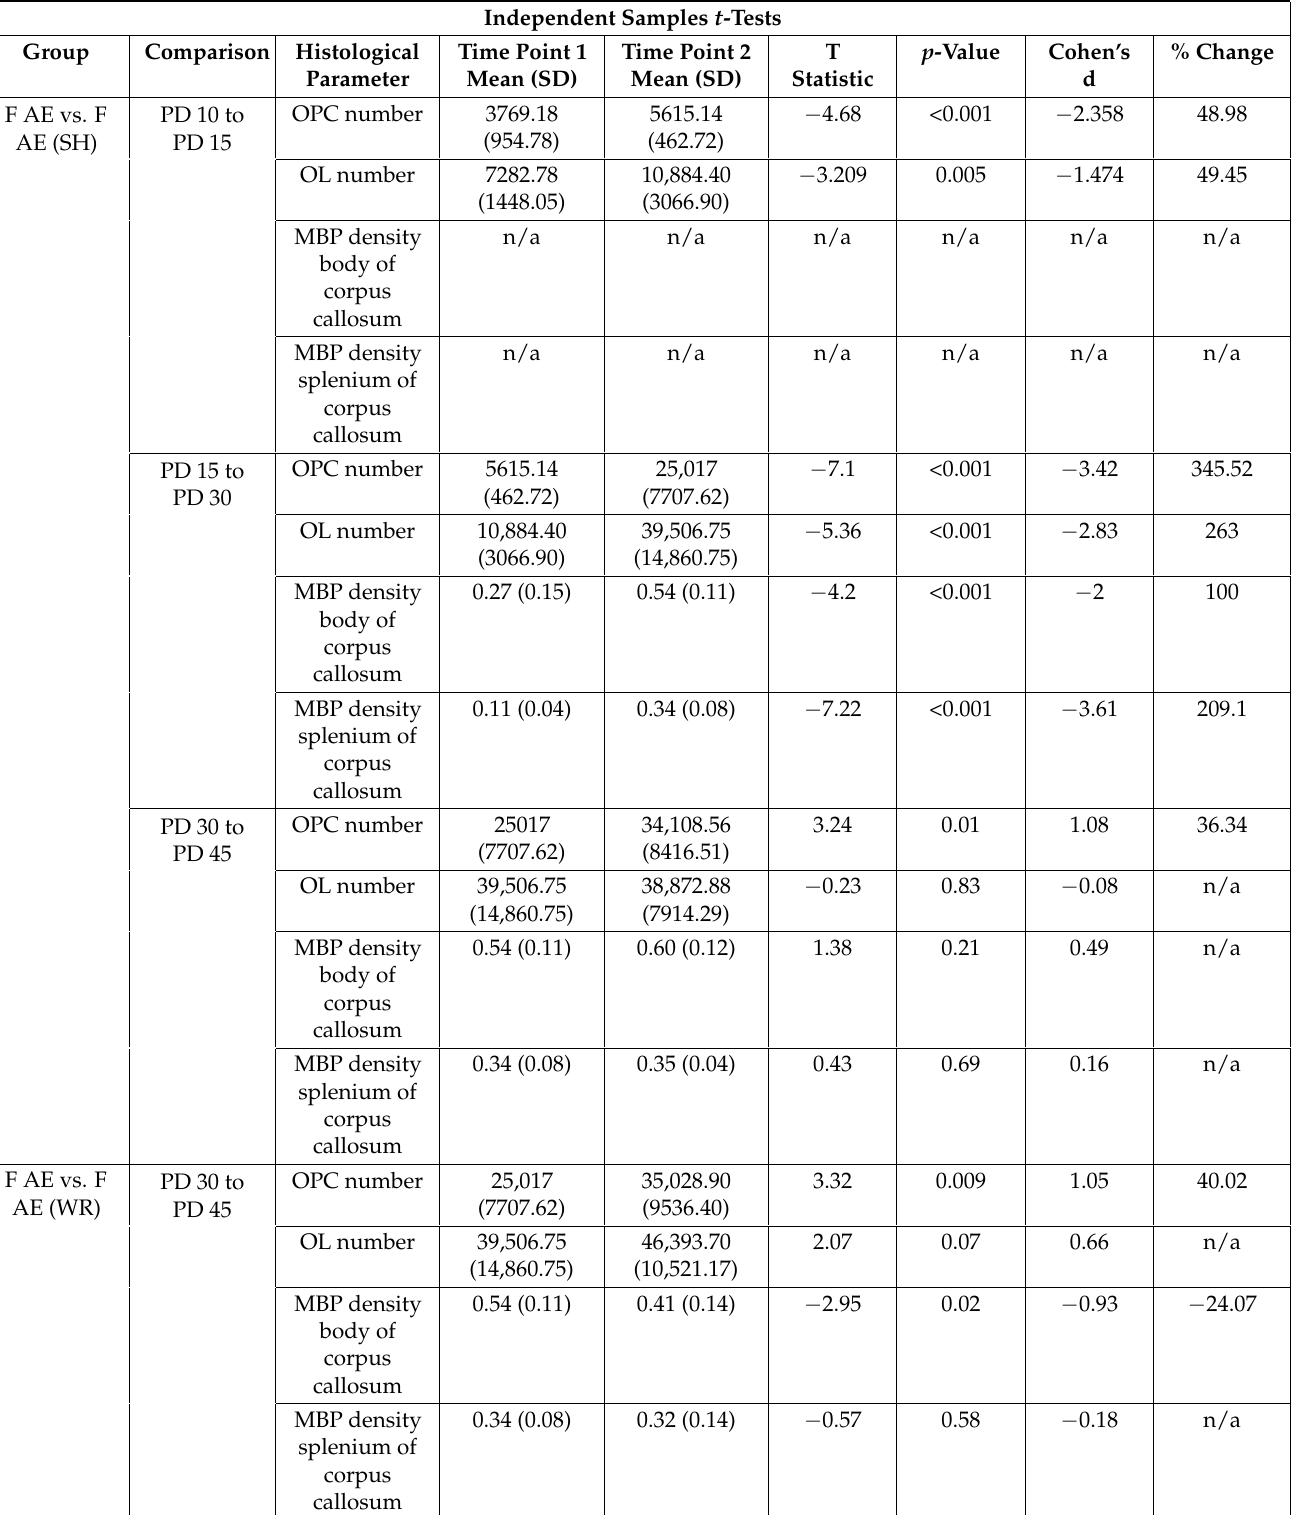
Table 2. Cont. Independent Samples t